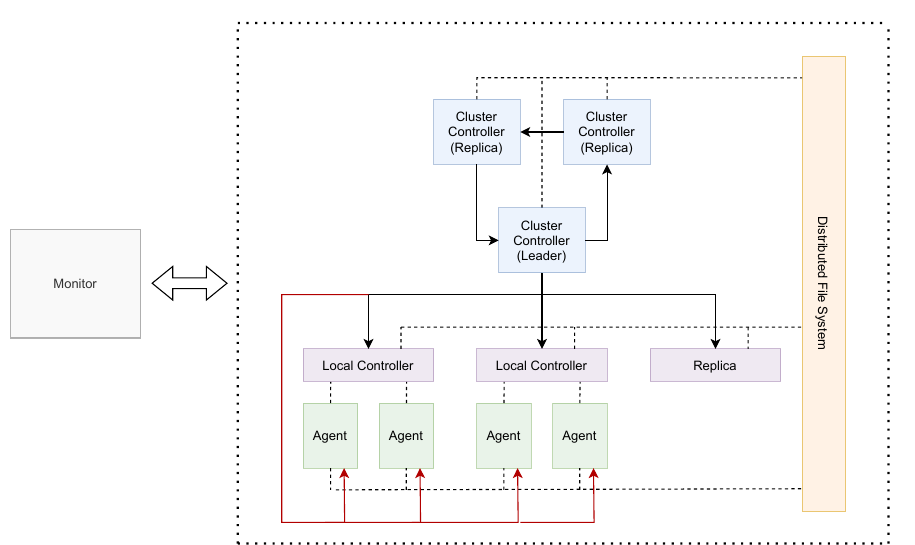
Figure 1. Áika’s architecture. Arrows represent client/server communication. Red arrows represent communication that may only occur during recovery. The figure does not include communication between agents. All nodes in the cluster are connected to a distributed file system that enables file sharing across the nodes. This is practical for recovery.